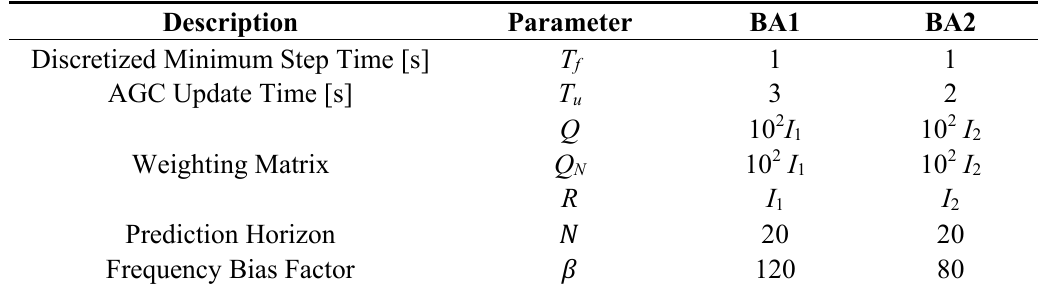
Table 4. Data and parameters for MPC-based AGC in each